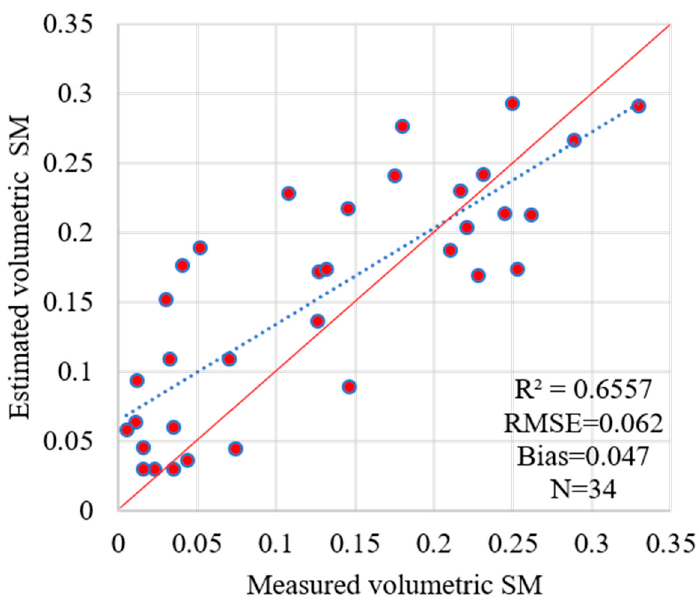
Figure10. Comparison between SM-retrieved soil moisture using the time series approach and in- situ-measured SM. situ-measured